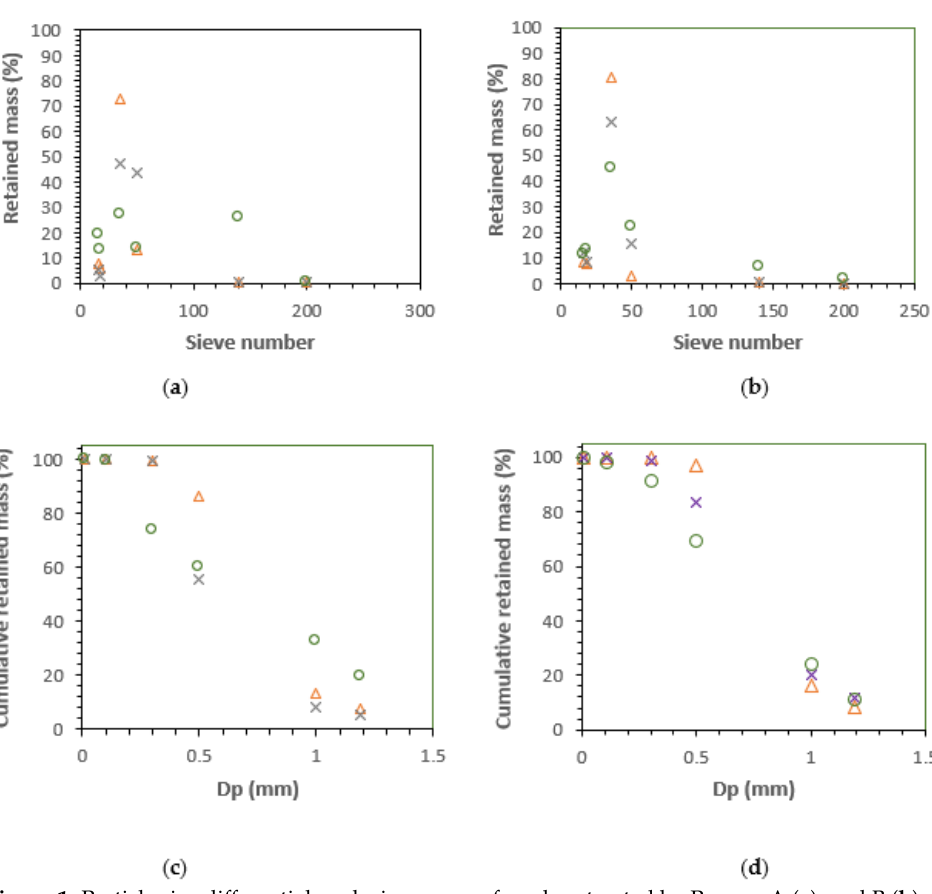
Figure 1. Particle size differential analysis process of seeds extracted by Process A ( a ), and B ( b ), and cumulative analysis of process A ( c ) and B ( d ). ( ∆ ) “Granadilla” ( Passiflora ligularis ), ( Χ ) “gulupa” ( P. edulis Sims fo edulis ), and ( О ) “curuba” ( P. mollissima ).